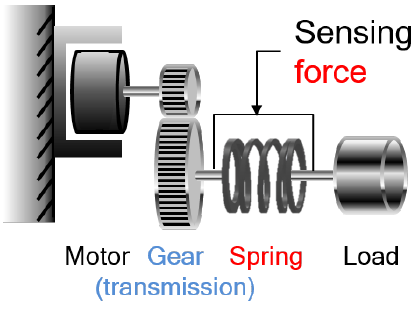
Figure 4. Configuration of Force-sensing Series Elastic Actuator (FSEA).